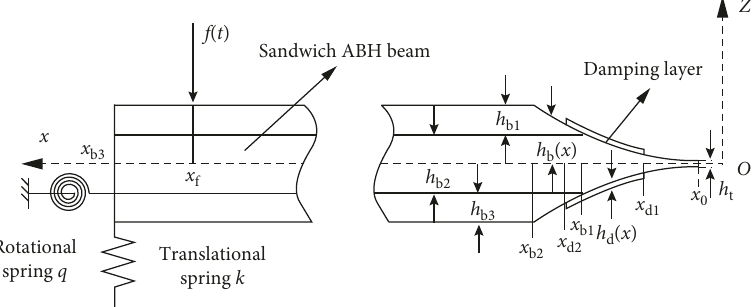
Figure 1: An Euler–Bernoulli sandwich beam with truncated